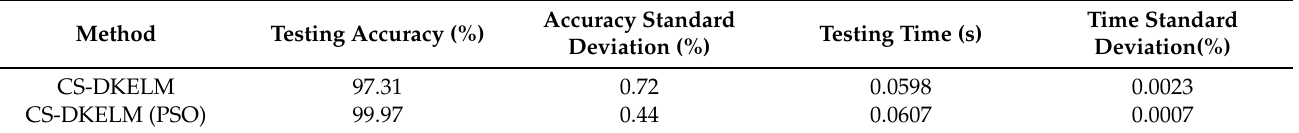
Table 3. The effect of PSO on diagnosis accuracy and time.